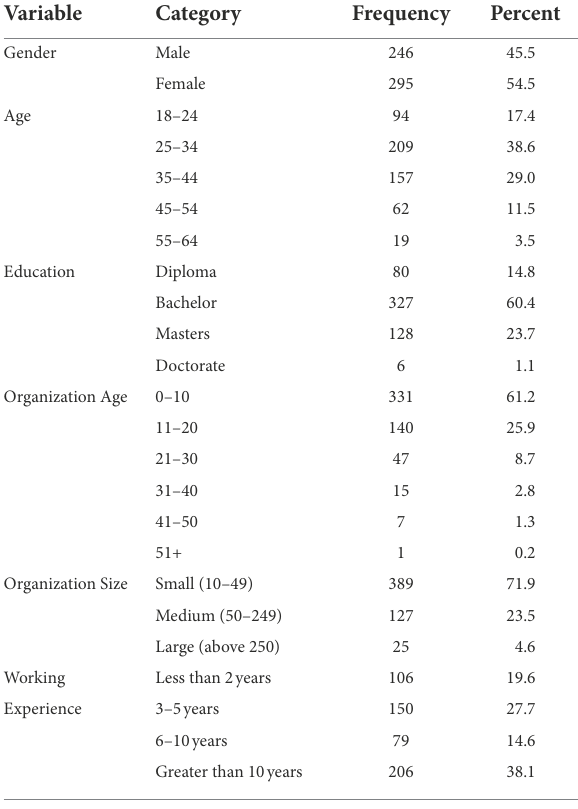
TABLE 2 Sample properties – N =